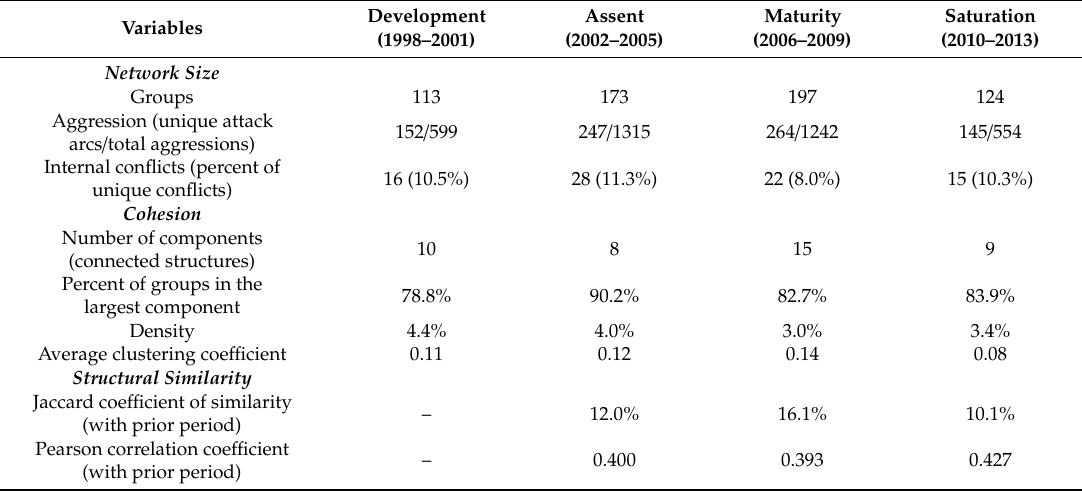
Table 1. Network Description by